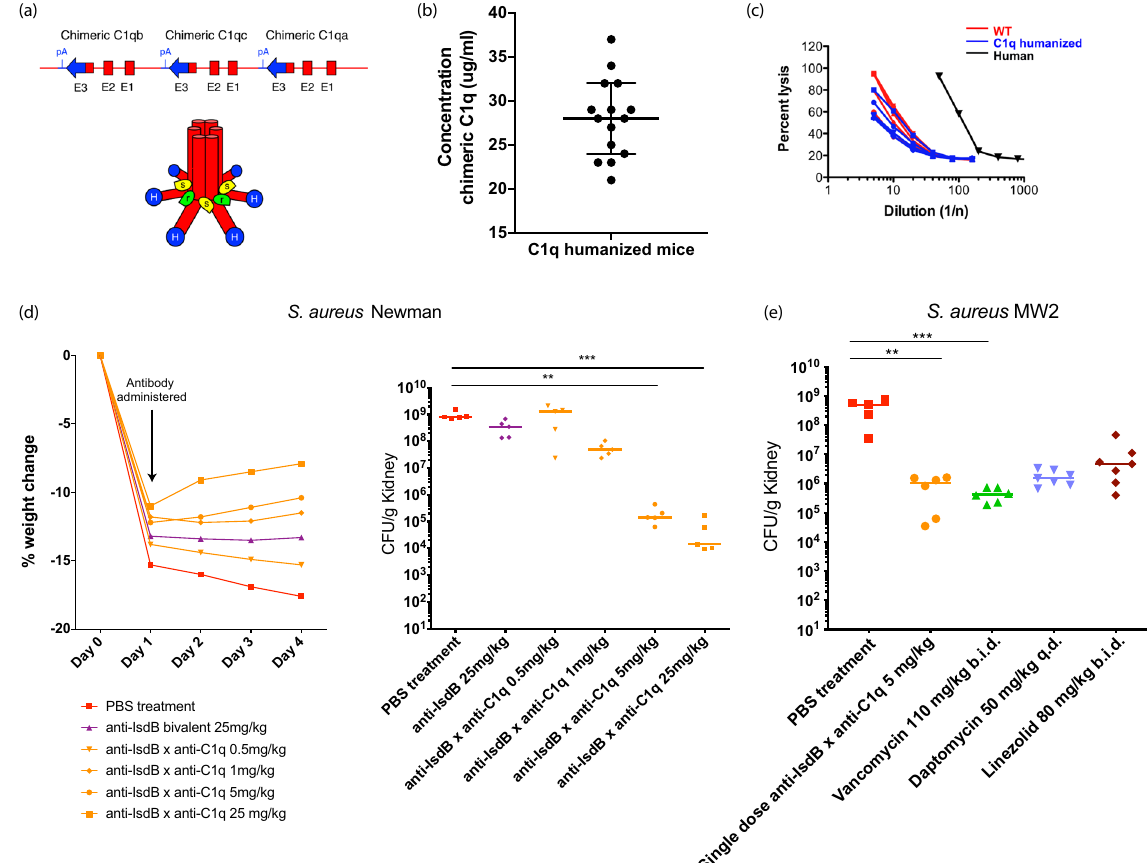
Figure 3. The IsdB x C1q bsAb increases clearance of S . aureus in mice with humanized C1q heads. ( a ) C1q humanized mice were produced by knocking out the mouse C1qA , C1qB and C1qC genes. They were replaced with chimeric versions of the genes in which the N-terminus of the gene encoding the collagen-like tail was mouse, but the C-terminus of the gene encoding the globular head was human. The resulting locus (not to scale) is shown with human sequences in blue and mouse sequences in red. C1q exons are labeled E1, E2, and E3. pA, polyA sequence (top). A representation of the resulting C1 complex is shown below. Human C1q heads are shown in blue, mouse C1q stalks are shown in red, mouse C1r is shown in green and mouse C1s is shown in yellow. ( b ) Quantitative measurement of the expression of chimeric C1q peptides was assessed via LC-MS/ MS. Serum was isolated from individual C1q humanized mice and the concentration of humanized mouse C1q specific peptides was determined. Results are plotted as median and interquartile range. ( c ) CH50 hemolysis assays were used to determine the activity of serum from humanized C1q mice. Sheep erythrocytes were sensitized to complement lysis by incubation with rabbit anti-sheep antibodies. Dilutions of wild-type and C1q humanized mouse serum, as well as human serum, were then added. Lysis of the red blood cells was used to determine the activity of the sera. ( d ) C1q humanized mice were infected with 1.5 × 10 8 CFU S . aureus Newman (MSSA strain). One day after infection, mice were treated with a single dose of the indicated antibody. Weights were recorded each day for four days and percent weight change compared to day 0 is shown (left). Mean weight change for each group of mice is plotted. On day 4, kidneys were harvested, dissociated, and serially diluted. Organ burden was determined by plating (right). The organ burden of each mouse is indicated along with the median value for each group. ( e ) C1q humanized mice were infected with 1.3 × 10 8 CFU S . aureus MW2 (MRSA strain) on day 1. One day after infection they were treated with either PBS (no treatment), a single dose of anti-IsdB x anti-C1q antibody, 110 mg/kg vancomycin twice daily, 50 mg/kg daptomycin once daily or 80 mg/ kg linezolid twice daily. On day 4, kidneys were harvested, dissociated, and serially diluted. Organ burden was determined by plating. The organ burden of each mouse is indicated along with the median value for each group. ( d , e ) ** P < 0.01, *** P < 0.001, nonparametric Kruskal-Wallis ANOVA with Dunn’s test showing values significantly different from the no treatment